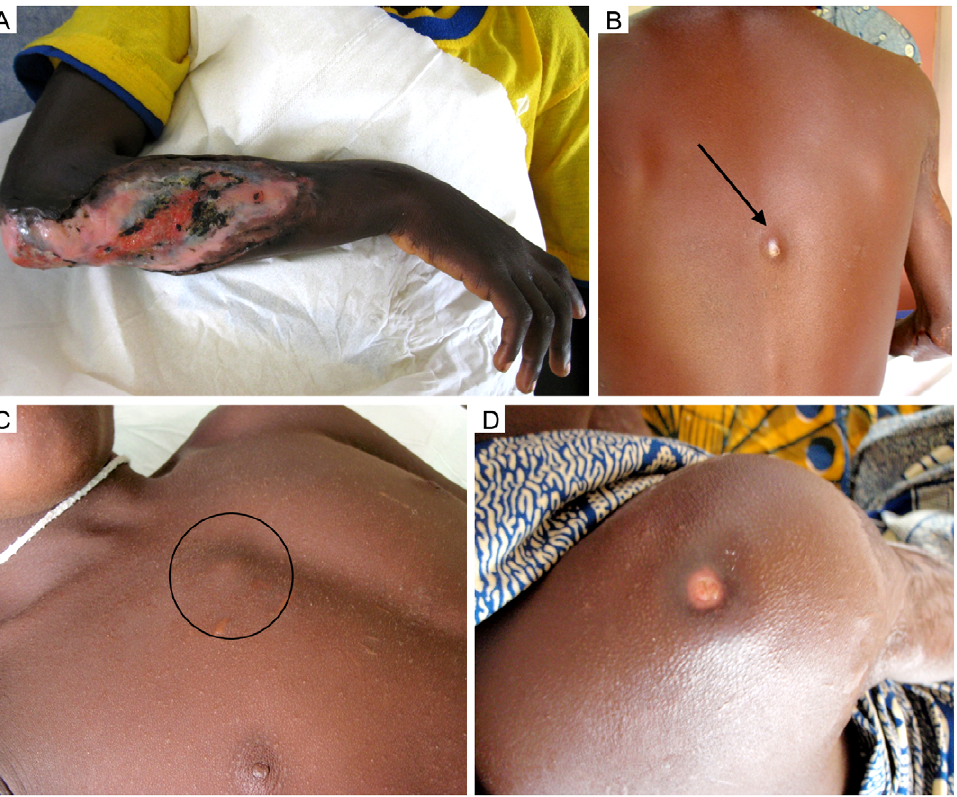
Figure 1. Clinical presentation of lesions (Patient 1). A: Initial ulcerated lesion at the right arm, reaching from the elbow to the forearm. B: Nodule1 appearing on the back, 275 days after end of antibiotic treatment. Both, nodule 2 on the thorax (C) and an ulcerated plaque on the right shoulder (D) had appeared 409 days after completion of antibiotic treatment.